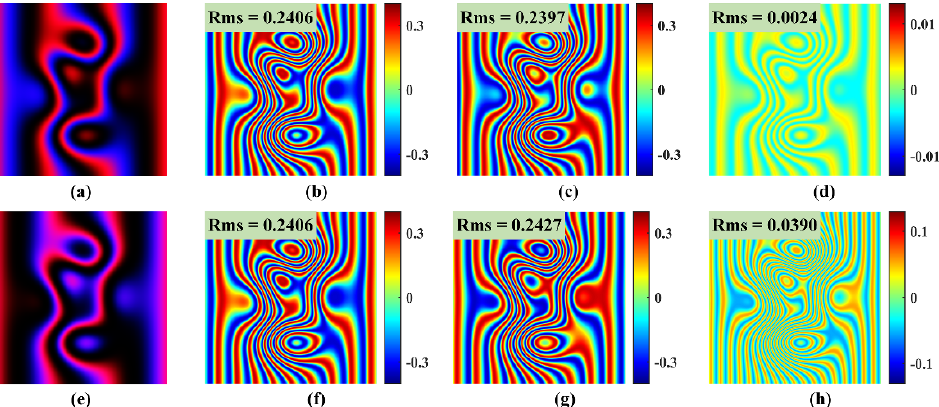
Figure 3. Comparison results when ignoring color crosstalk. ( a ) Color fringe generated by the proposed IDTP algorithm, and the corresponding phase errors of ( b ) the red channel, ( c ) the blue channel, and ( d ) the average fringe, respectively. ( e ) Color fringe generated by the conventional PDTP algorithm, and the corresponding phase errors of ( f ) the red channel, ( g ) the blue channel, and ( h ) the average phase,